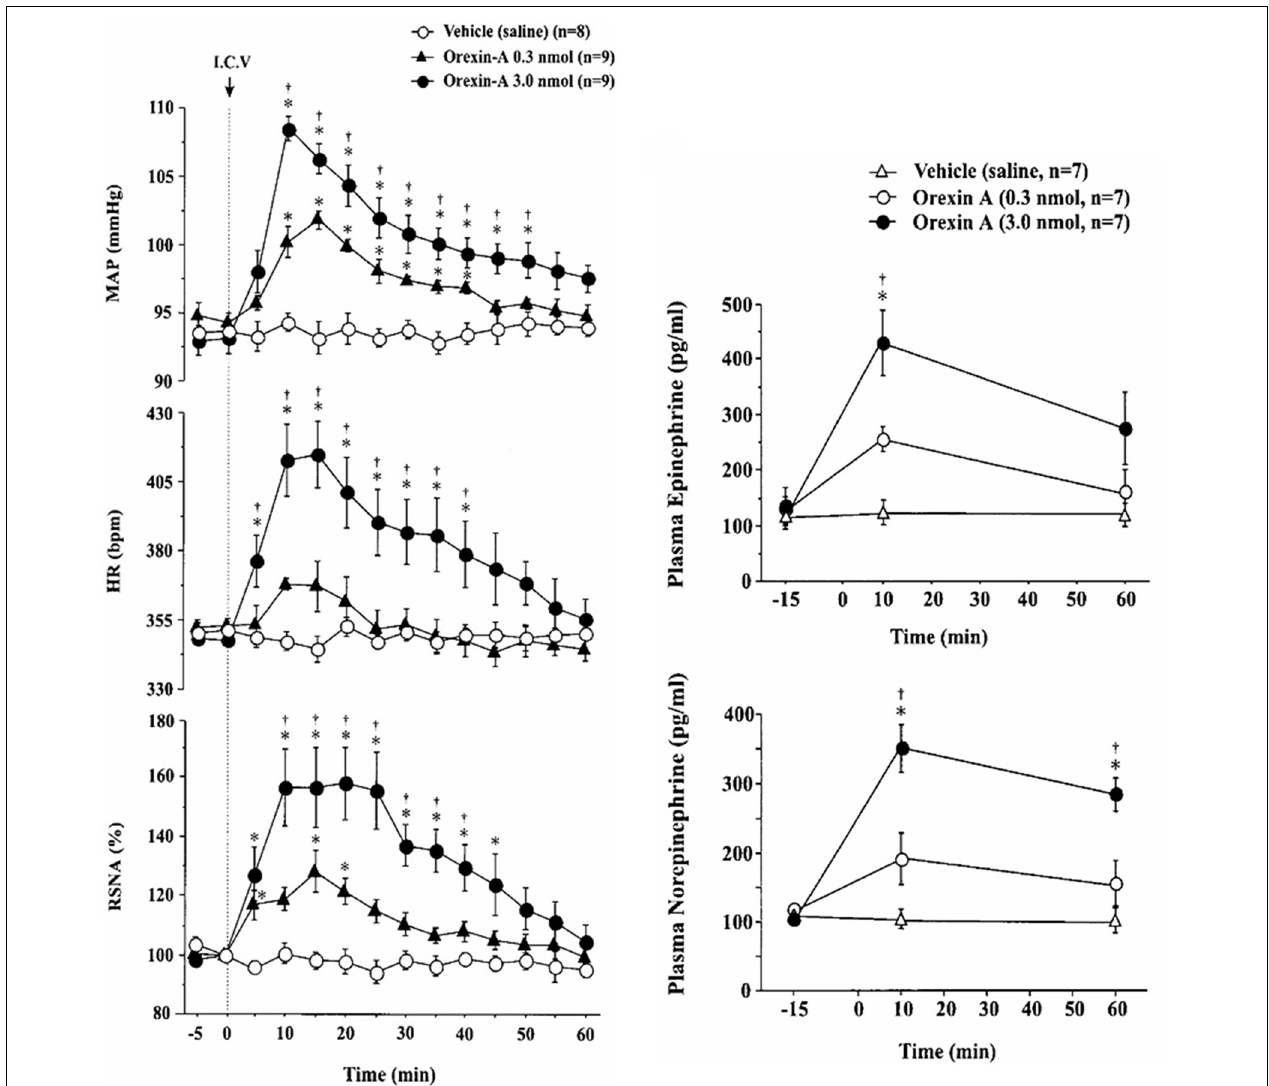
FIGURE 4 | Central application of OX-A increases mean arterial blood pressure (MAP), heart rate (HR) and renal sympathetic nerve activity (RSNA) in conscious rats. Intracerebroventricular injection of OX-A increases MAP, RSNA, HR, and catecholamine release in conscious rats in a dose dependent manner. Orexin-A (0.3, 3.0nmol) provoked an increase in